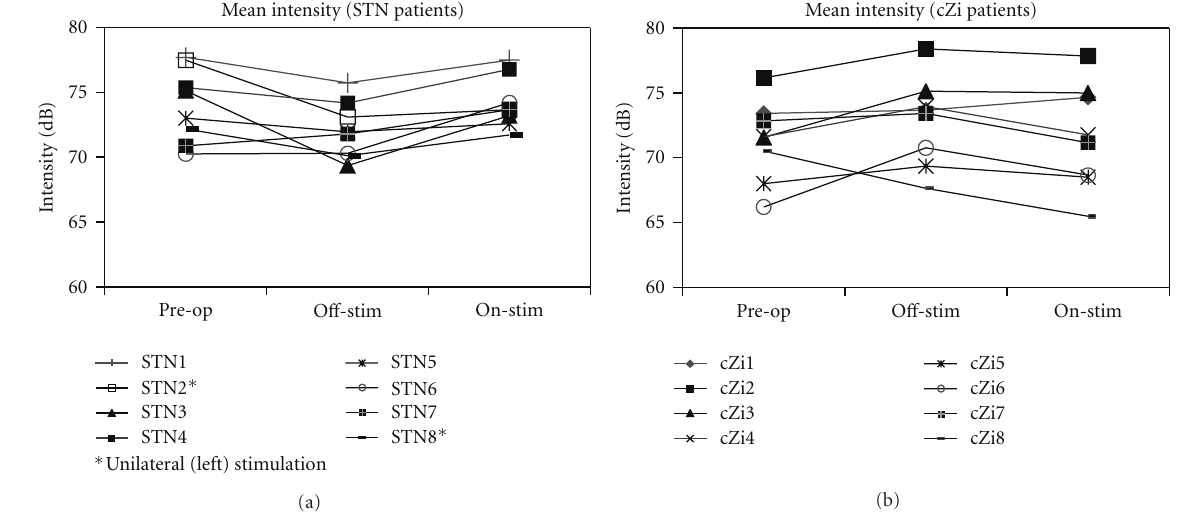
Figure 2: Mean intensity during reading for individual patients in STN and cZi groups.